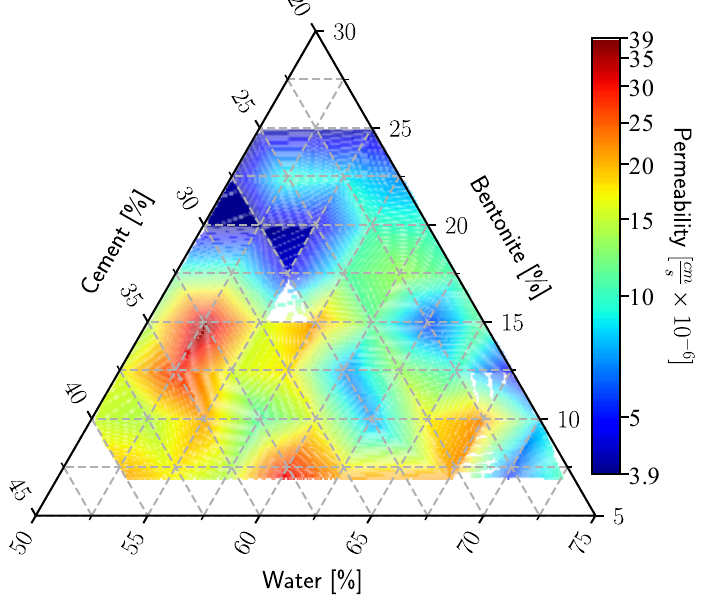
Figure 8. Permeability.